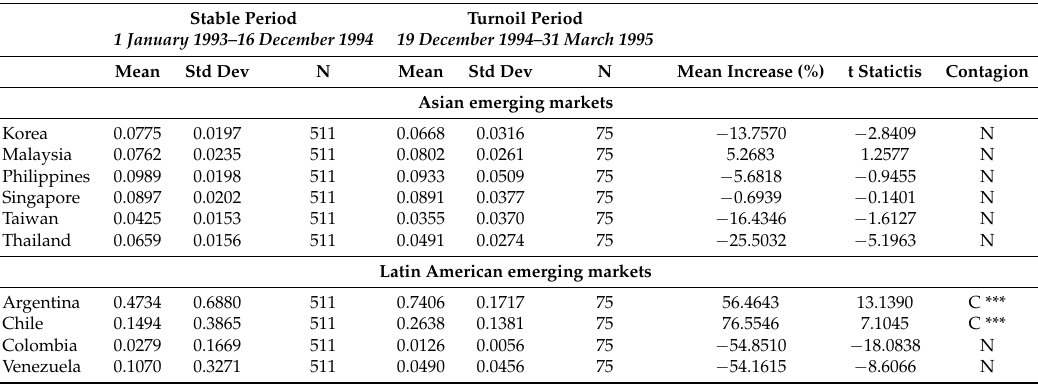
*** represents statistical significance at the 10% level of risk. N: No contagion; C: Contagion. Table 9. Results of contagion test in emerging stock markets: The Asian “flu” crisis in 1997 (Contagion source: Thailand). Stable Period